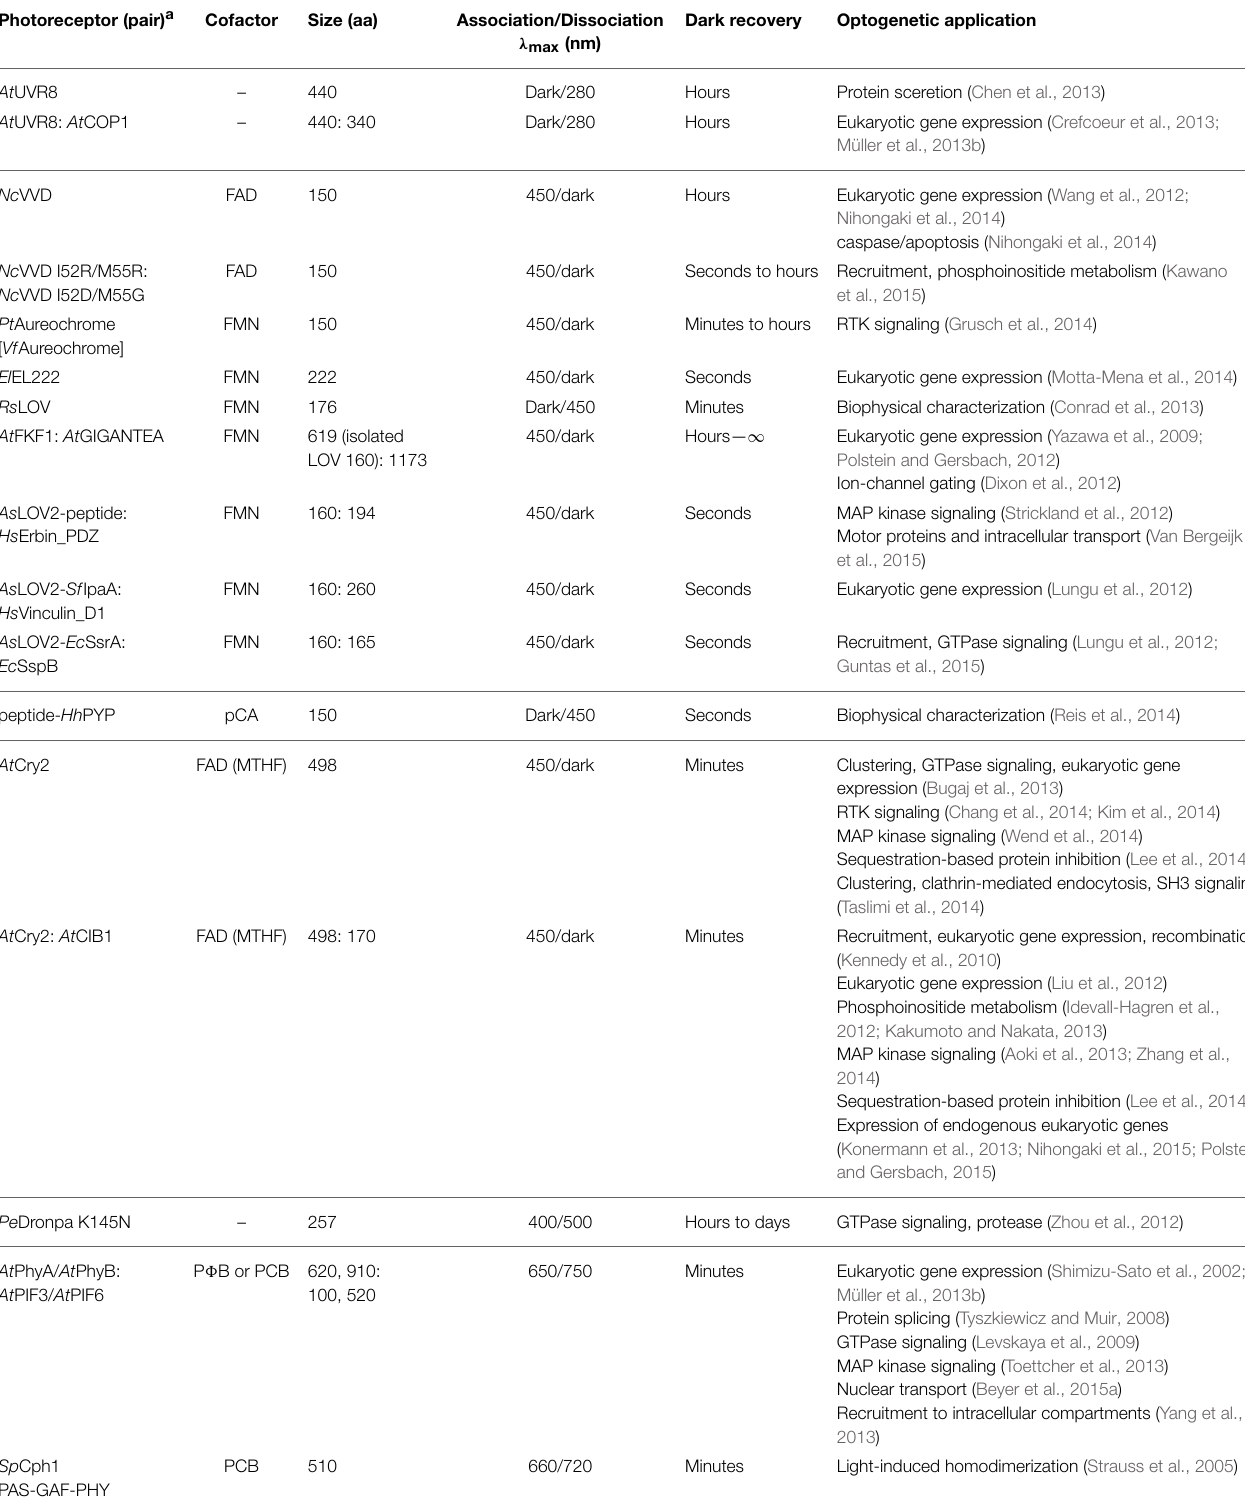
a Species abbreviations cf. Table 1 and as follows: El, Erythrobacter litoralis; Nc, Neurospora crassa; Pe, Pectiniidae cDNA; Pt, Phaeodactylum tricornutum; Rs, Rhodobacter sphaeroides; Sf, Shigella flexneri; Vf, Vaucheria frigida.